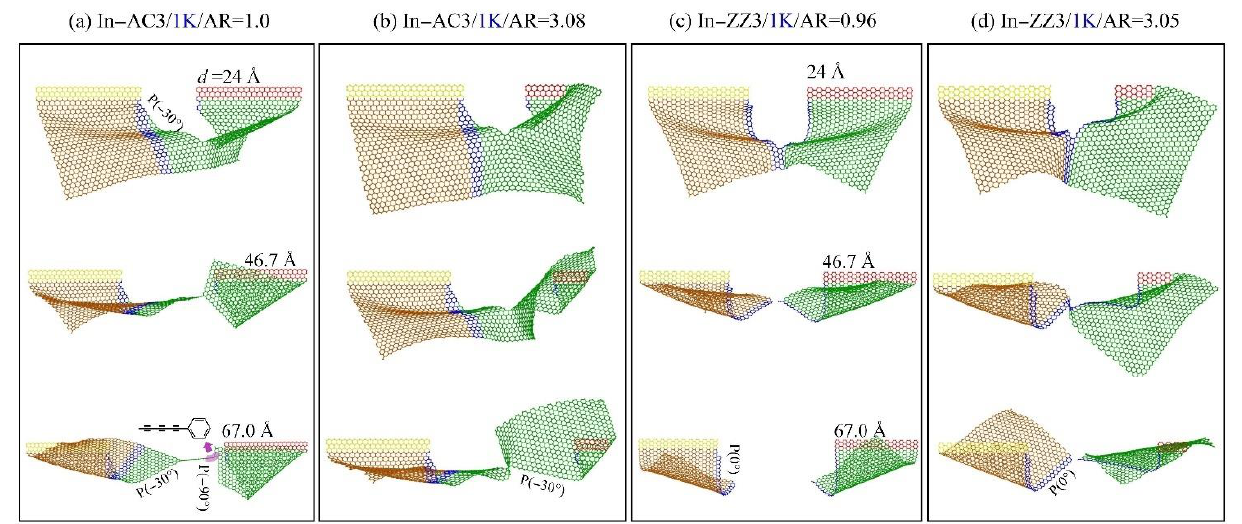
Figure 5. Snapshots of the sheets in an in-plane tearing with v = 0.4 Å /ps at 1 K: ( a , b ) In-AC3 with AR = 1.00 or 3.08, respectively; ( c , d ) in-ZZ3 with AR = 0.96 or 3.05, respectively.